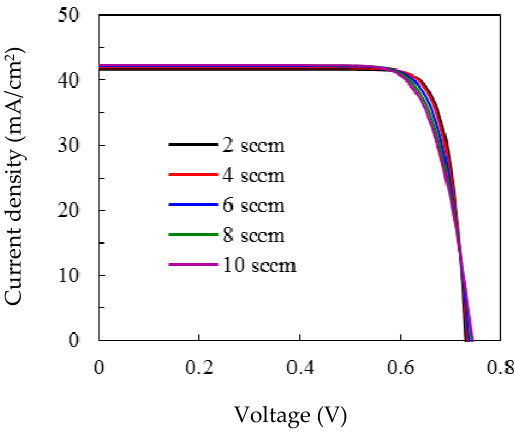
Figure 5. Simulated J-V curves of SHJ solar cells with different p-type emitters. Table 3. External photovoltaic parameters for SHJ solar cells with different p-type emitters. CO 2 (sccm) V oc